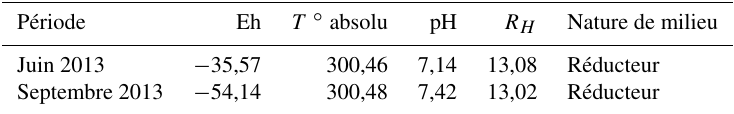
Tableau B2. Pouvoir oxydant de l’eau en juin et septembre.